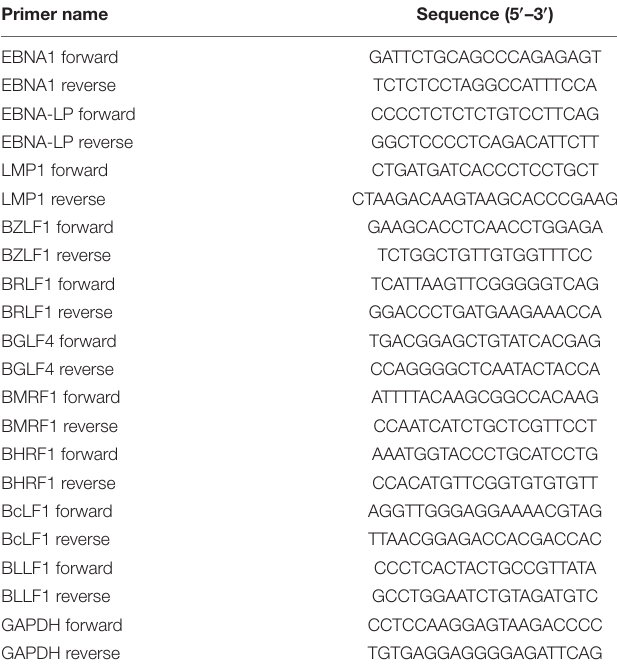
TABLE 5 | Oligonucleotide primers used for qRT-PCR. Primer